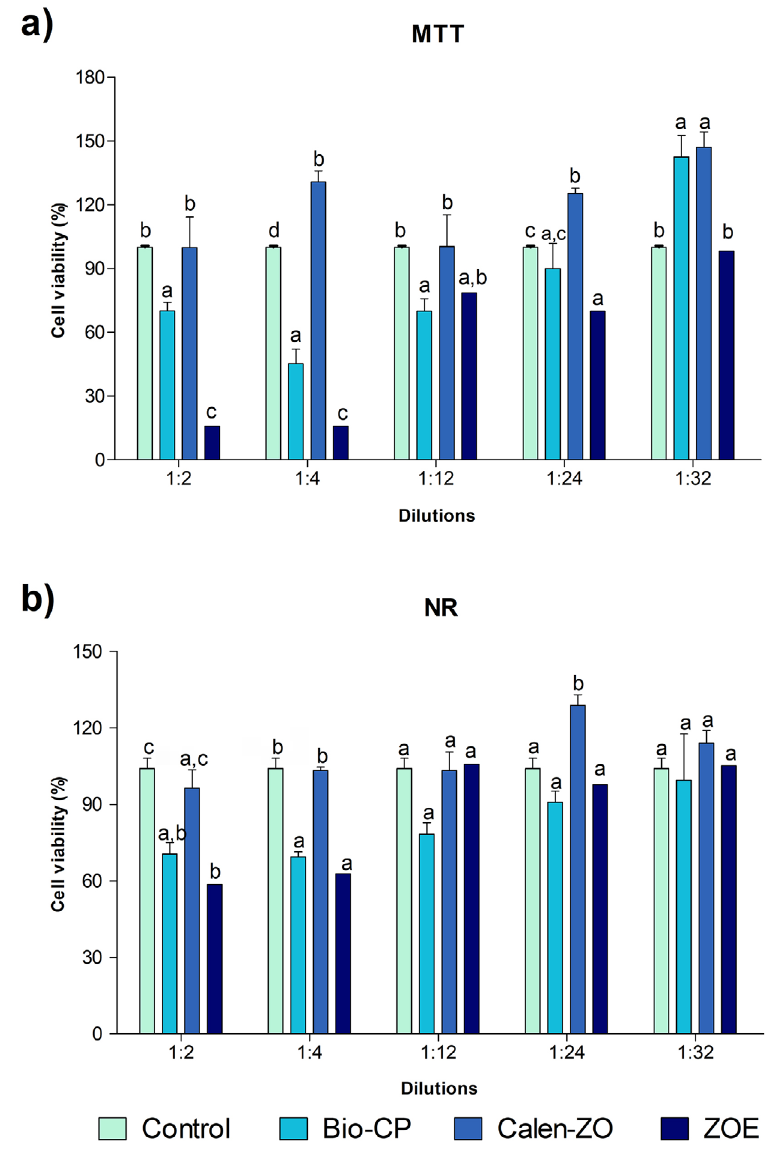
Figure 2- Saos-2 viability evaluated by (a) methyl-thiazol-tetrazolium (MTT) and (b) neutral red (NR) assays, after 24 hours of exposure to Bio-CP, Calen-ZO, ZOE and control (culture medium). Bio-CP=Bio C Pulpecto; Calen-ZO=Calen mixed with zinc oxide; ZOE=Zinc oxide and eugenol. Different letters in each dilution indicate statistically significant differences among the materials